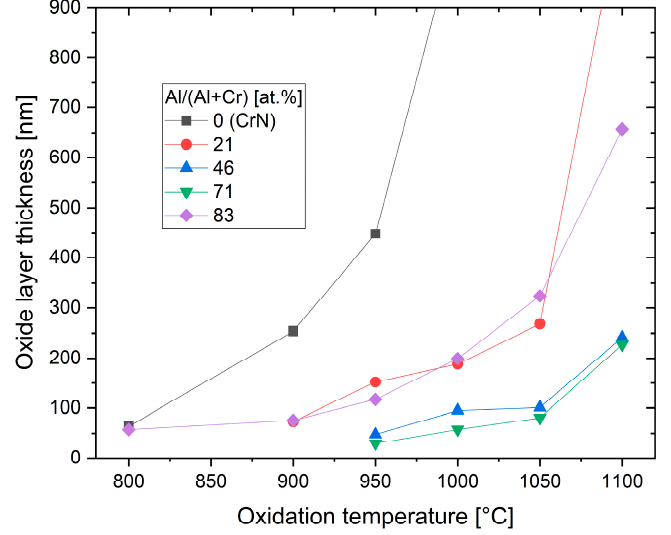
Figure 13. Thickness of oxide layer for CrN, (CrAl)N and (AlCr)N coatings after annealing at different temperatures in an air atmosphere, redrawn after [61], original © Elsevier.